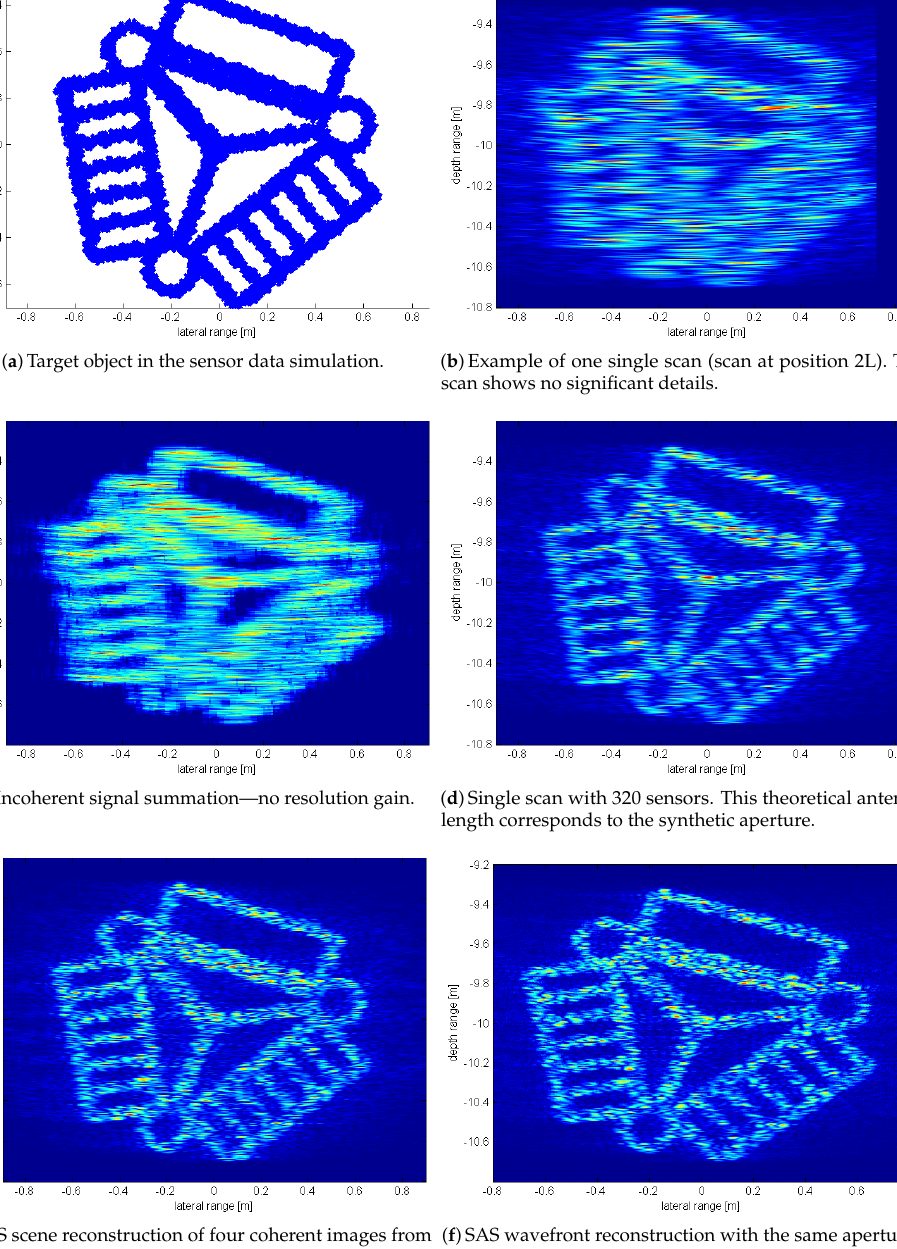
Figure 11. 2D imaging example according to the SAS wavefront reconstruction (see Section